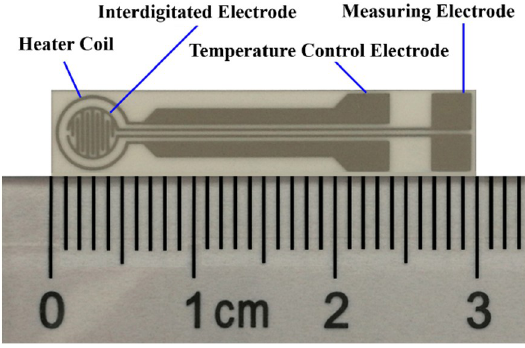
Figure 1. The TC-5010 sensor substrate.